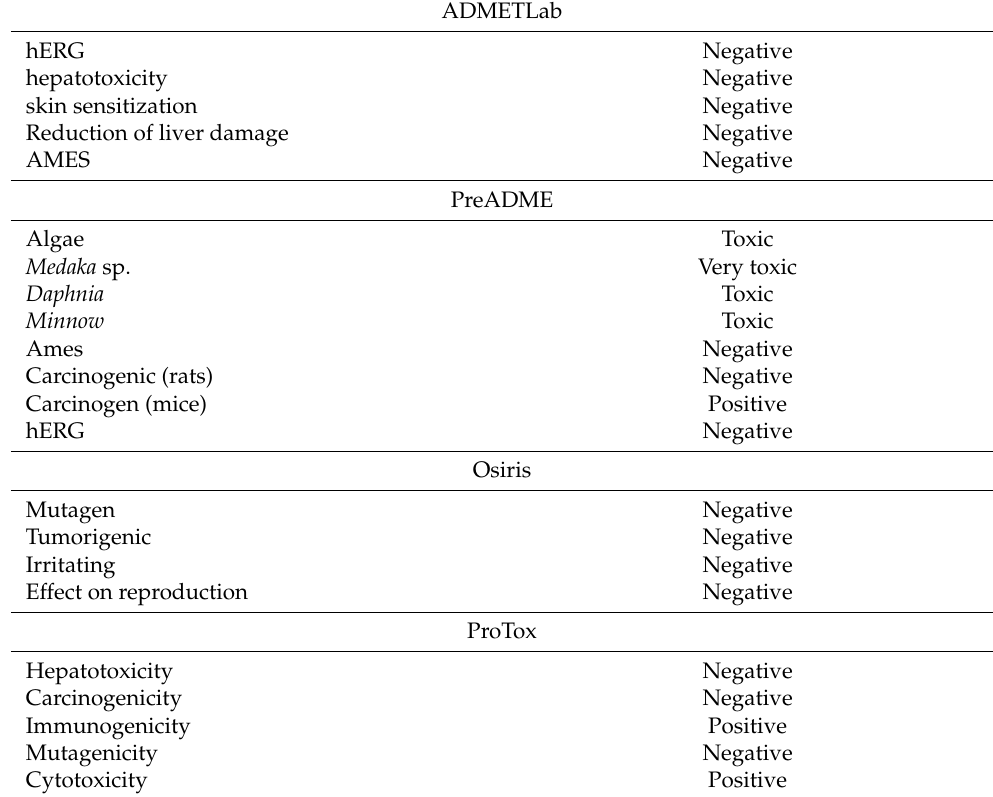
Table 4. Annonacin toxicity